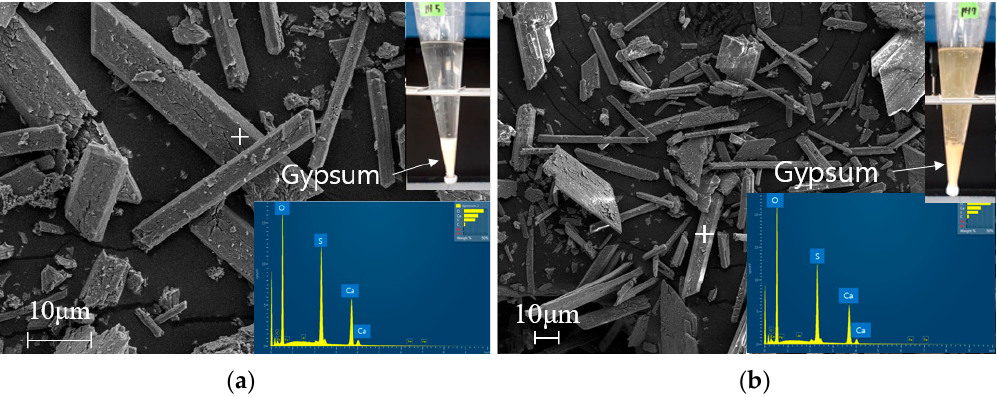
Figure 7. White precipitates (gypsum) in Imhoff cones at ( a ) pH 5 and ( b ) pH 9 and their SEM/EDS analysis results.